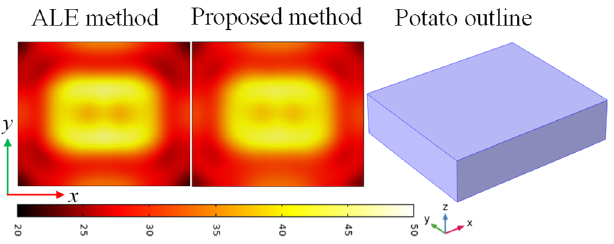
Figure 7. Outline of potato and temperature distributions on the upper surface of the potato obtained by the ALE method and the proposed method at the 10th second (top view, unit: ℃ ).